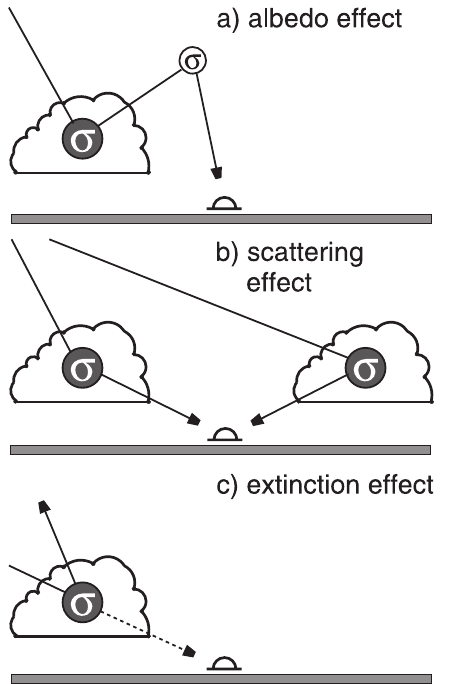
Fig. 1a–c. Influence of remote clouds on surface UV irradiance. The albedo and scattering e(cid:128)ect enhance surface UV irradiance, whereas the extinction e(cid:128)ect leads to a decrease. In cases a and b scattering of photons by remote clouds increase the di(cid:128)use skylight at the observation site, while in case c remote clouds redirect photons that otherwise would have reached the observer. The white r in the dark circle symbolizes cloud scattering, while the black r indicates atmospheric backscattering